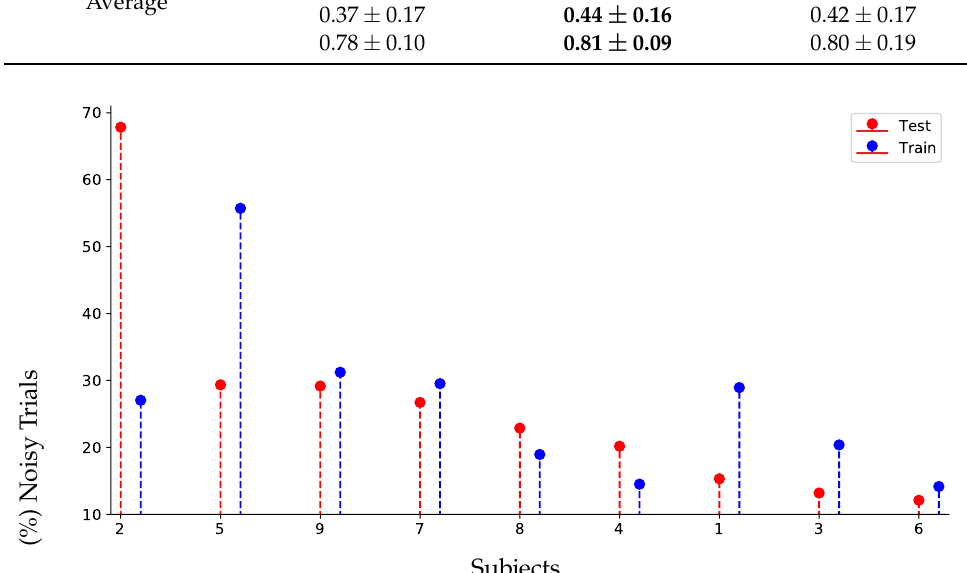
Figure 4. Percentage of noisy trials of each subject identified by the ICA-based artifact removal strategy in the training and testing stage of